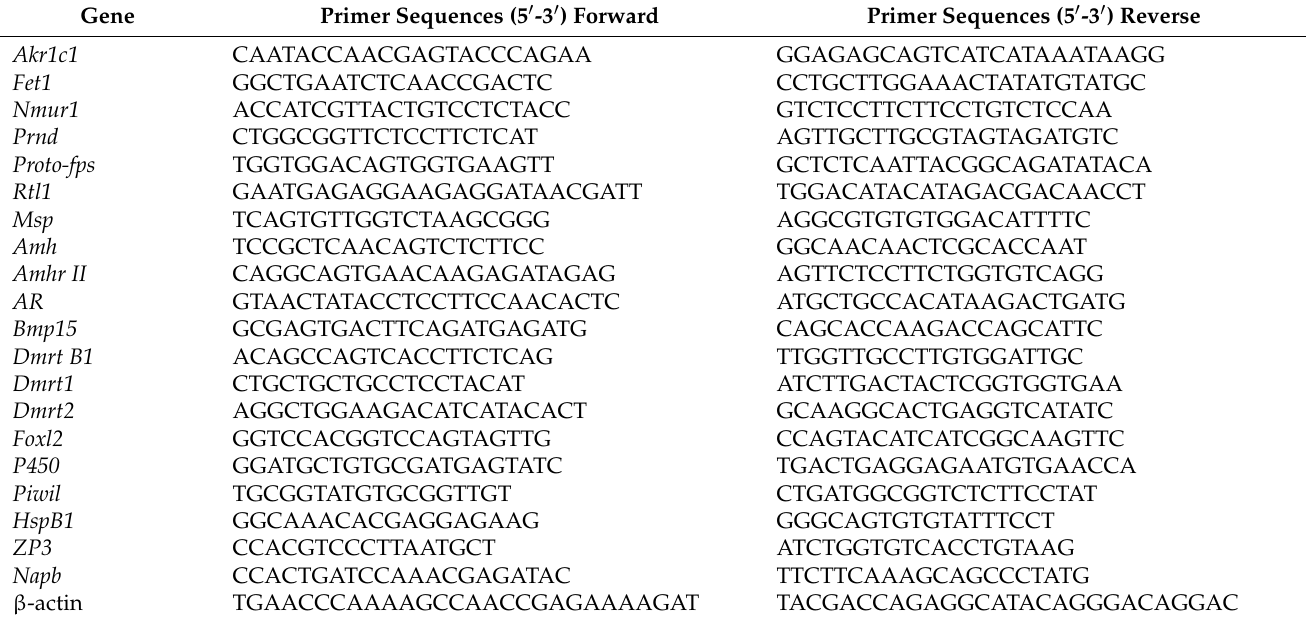
Table 1. Primers used in real-time quantitative